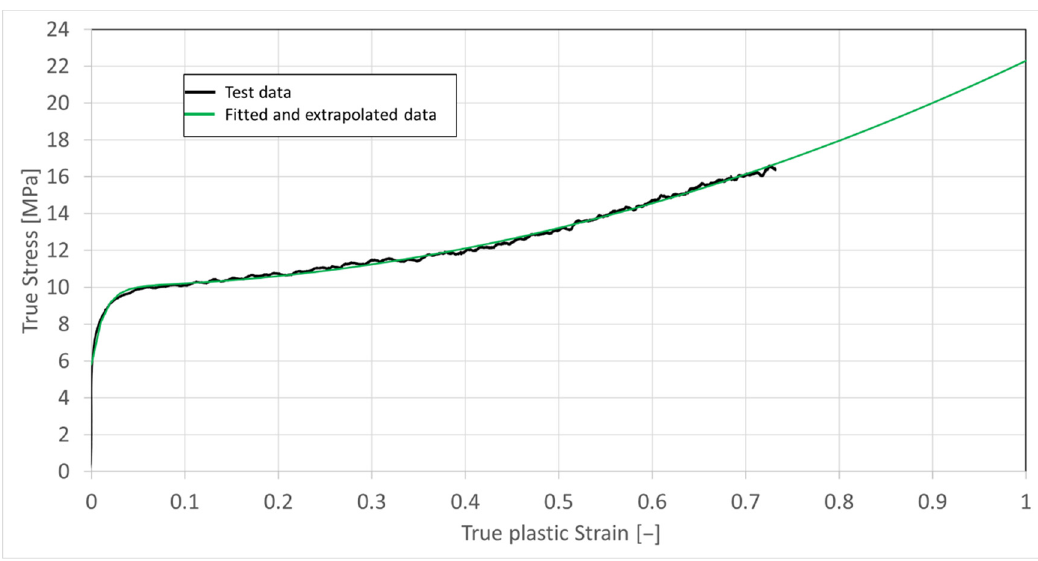
Figure 9. Hardening curve from real test (black curve) vs. calculated curve based on G’Sell’s equation.